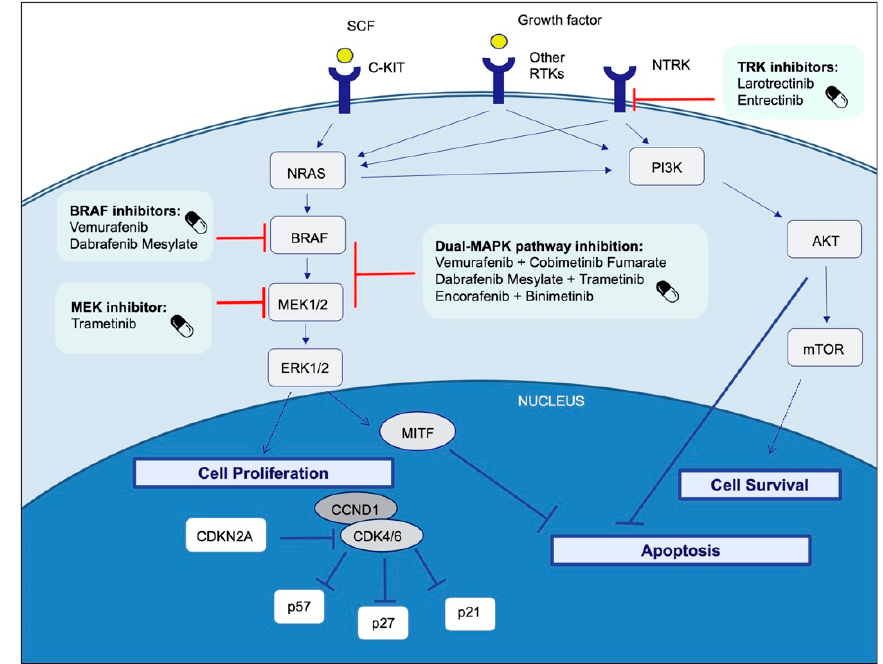
Figure 3. Melanoma US Food and Drug Administration-approved targeted therapy.